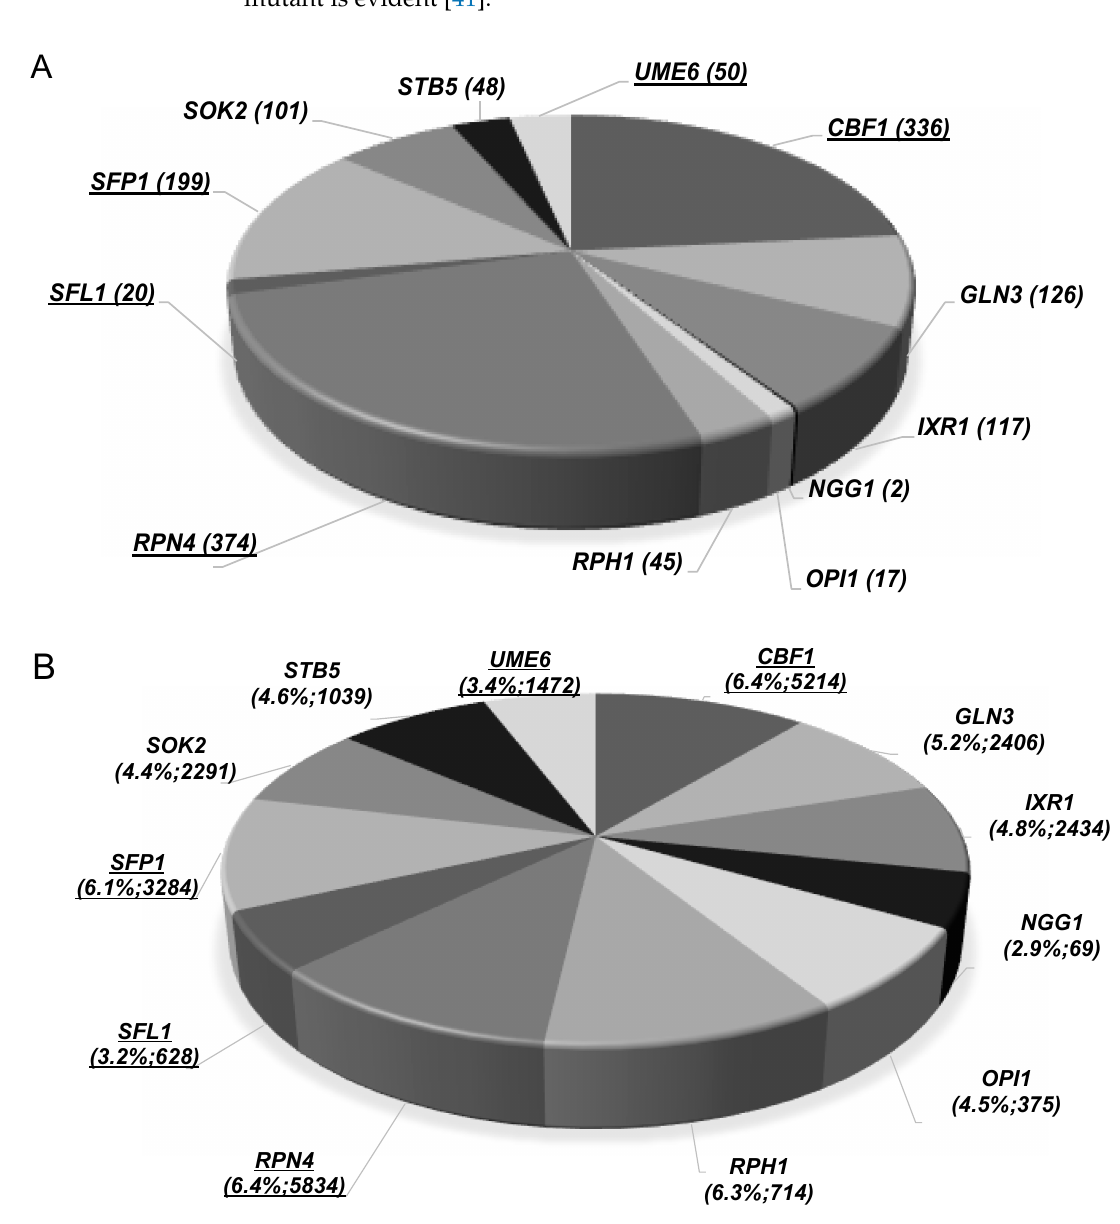
Figure 4. Clustering of methanol-tolerance genes that are targets of transcription factors (TF) that also exert protection against this alcohol. ( A ) Number of target genes (into brackets) for each TF that are required for methanol tolerance. ( B ) Percentage of methanol tolerance genes regulated by each TF relatively to the total number of genes of each described regulon. Methanol tolerance genes were clustered in association with their documented regulators using the information available in the Yeastract database (December 2020). The TFs found to exert protection only against methanol are in bold; the TFs underlined and in bold are those found in the methanol and ethanol